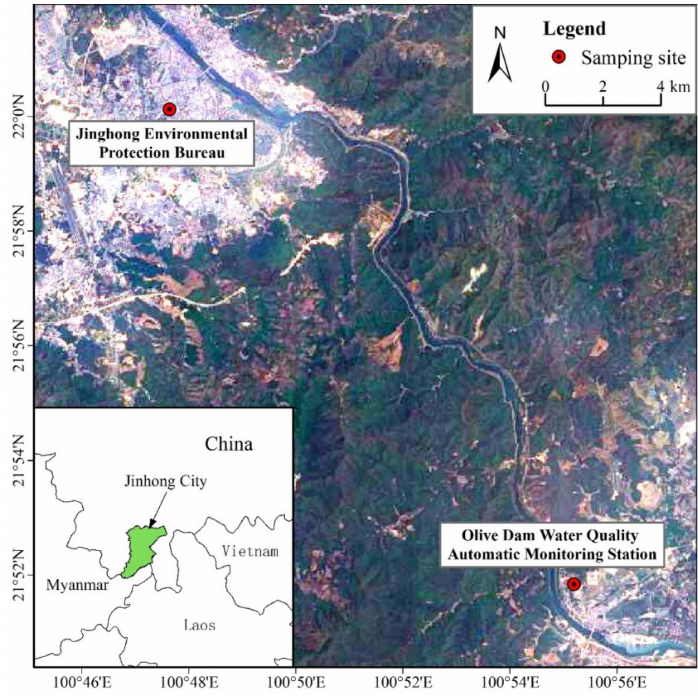
Figure 1. Sampling sites of VOCs in